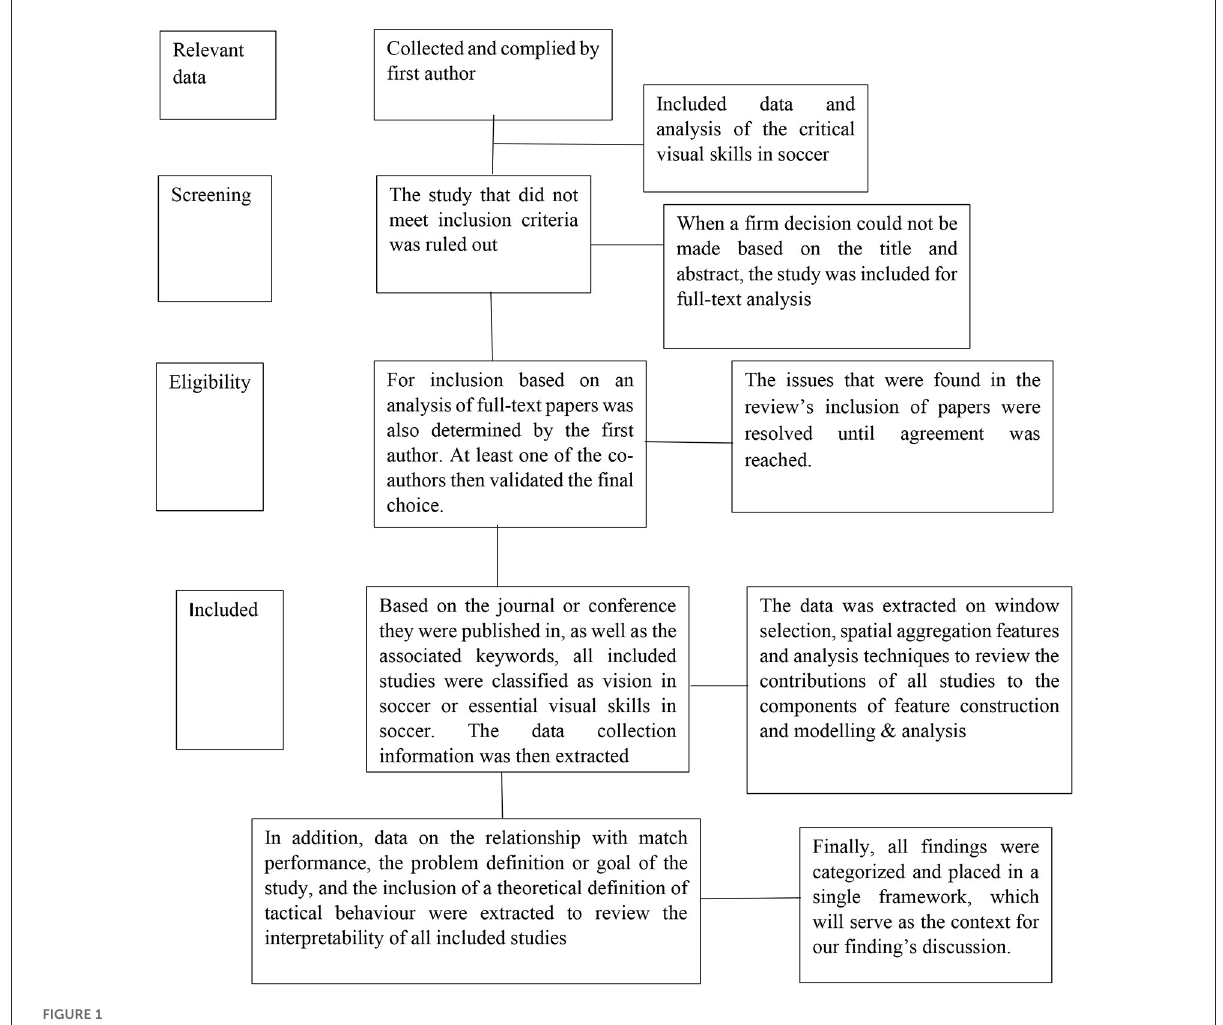
FIGURE1 Data extraction.